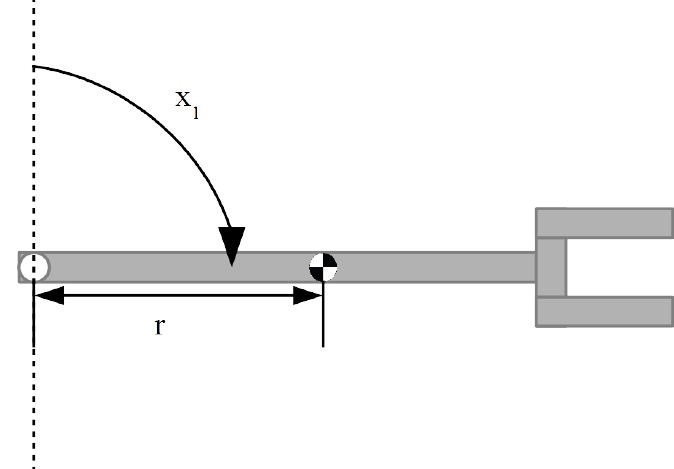
Figure 1. Scheme of the